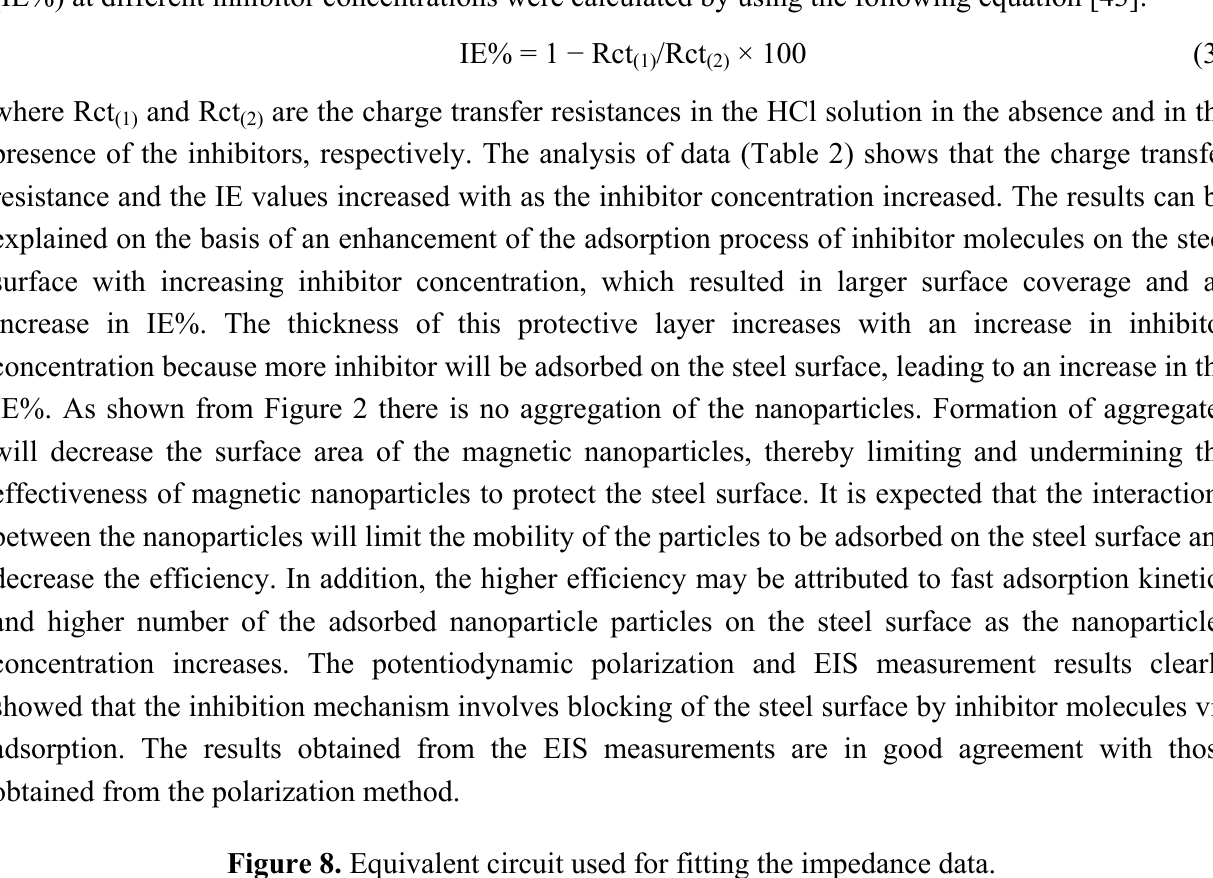
Figure 8. Equivalent circuit used for fitting the impedance